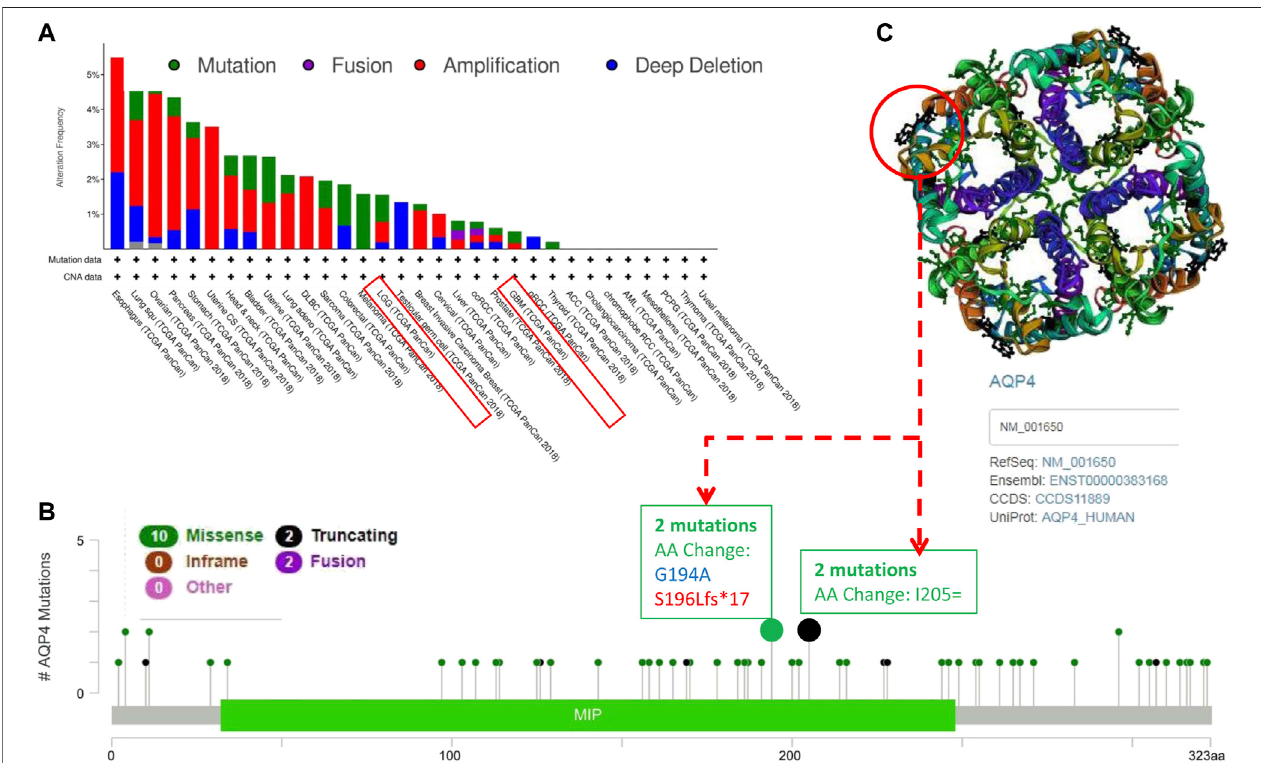
FIGURE2| MutationpatternsofAQP4acrossdifferentcancersintheTCGAdatabase.UsingthecBioPortaltool,SNRPGmutationspresentintumorsintheTCGA databasewereanalyzed.Thealterationfrequencywithmutationtype (A) andmutationsite (B) aredemonstrated.Wedisplaythemutationsiteswiththehighestalteration frequency in the 3D structure of SNRPG (C)